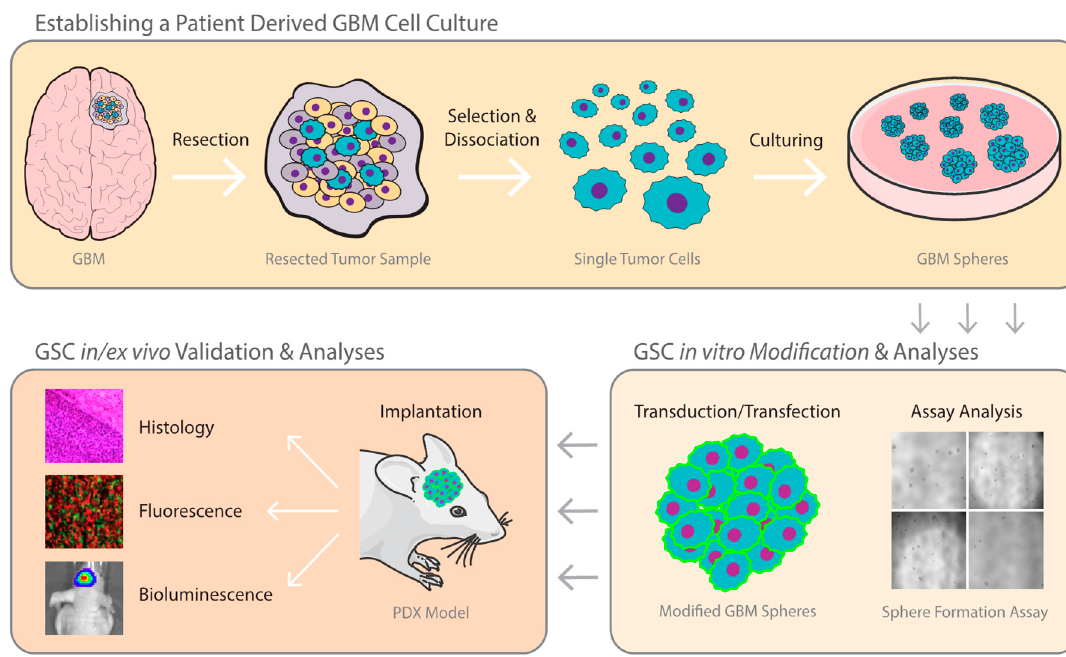
Figure 1. Glioblastoma model from patient to dish to animal. Typical workflow of establishing patient-derived glioblastoma (GBM) models. (Top) Tumor sample obtained from resective surgery is dissociated and single tumor cells are selected. Culturing with adequate growth conditions will facilitate the formation of GBM neurospheres. (Bottom Right) Obtained neurospheres can be tested for various properties, such as stemness, clonogenic potential, and viability; or can be engineered to express different proteins of interest or reporters for cell tracking. (Bottom Left) GBM neurospheres can be used to establish patient-derived xenografts (PDX) to study tumor biology and to test novel